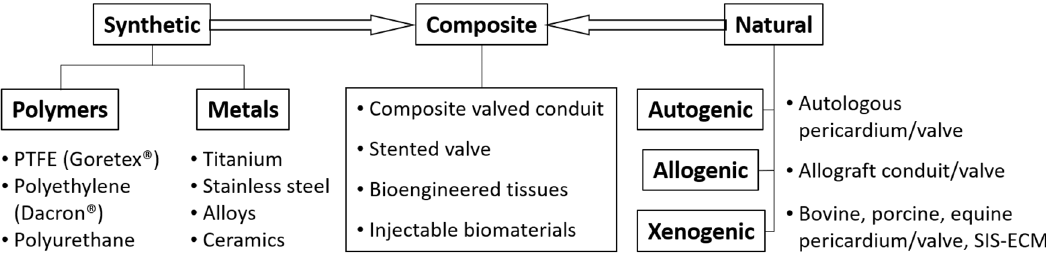
Figure 1. Biomaterials used in congenital and pediatric cardiac surgery. Examples shown herein for illustration and are not all-inclusive. Composite category defines biomaterials that conjoin natural biomaterials with synthetically manufactured scaffolds. Abbreviations: PTFE: polytetrafluoroethylene, SIS-ECM: small intestine mucosa extracellular matrix.